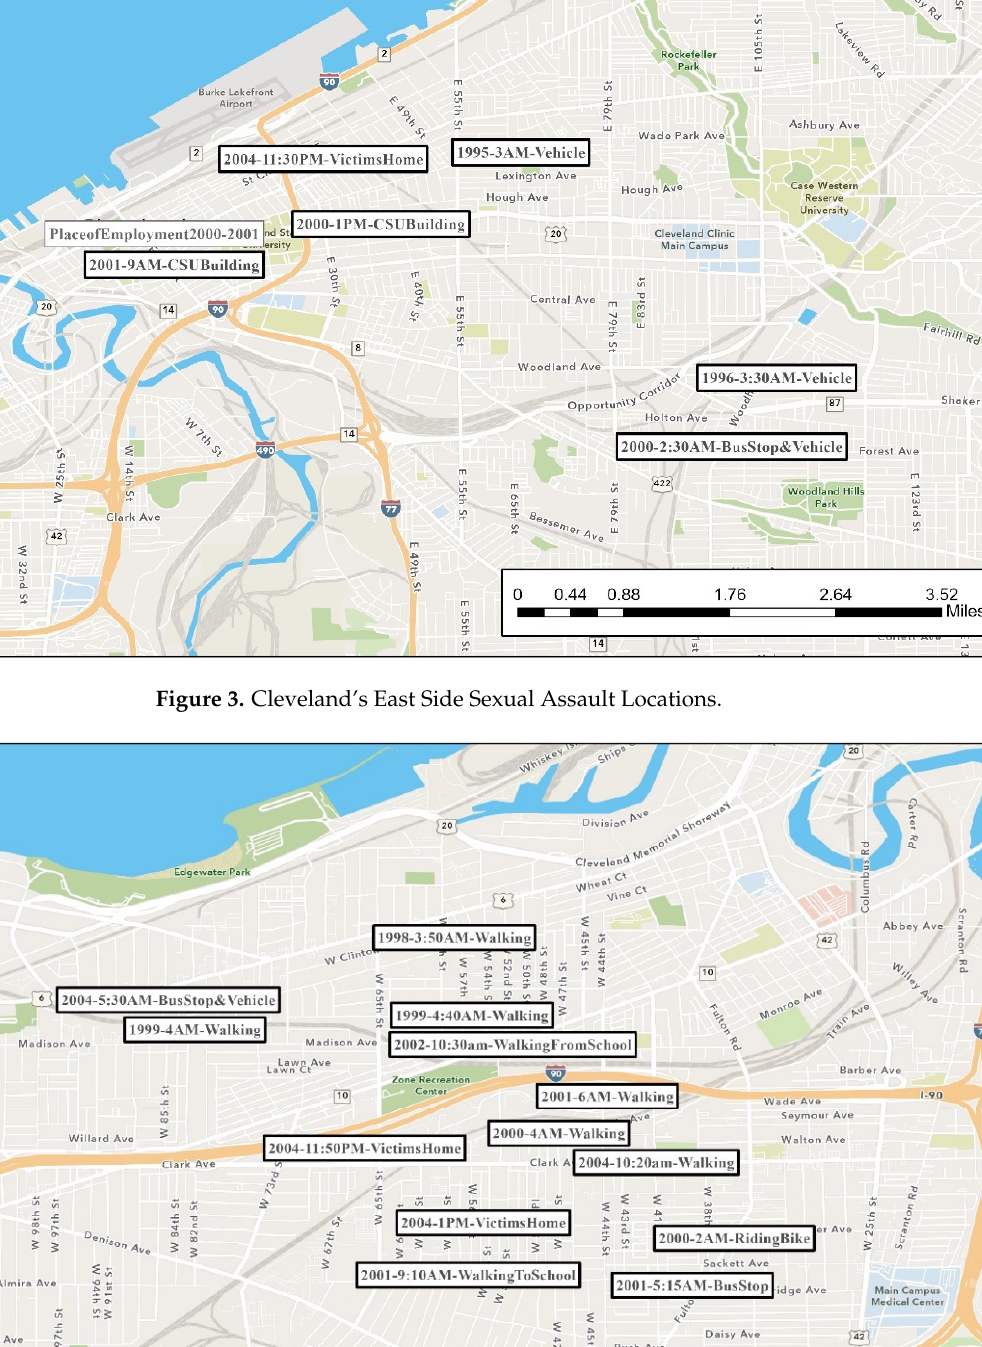
Figure 2. Offender’s Awareness Space, Sexual Assault Heat Map.